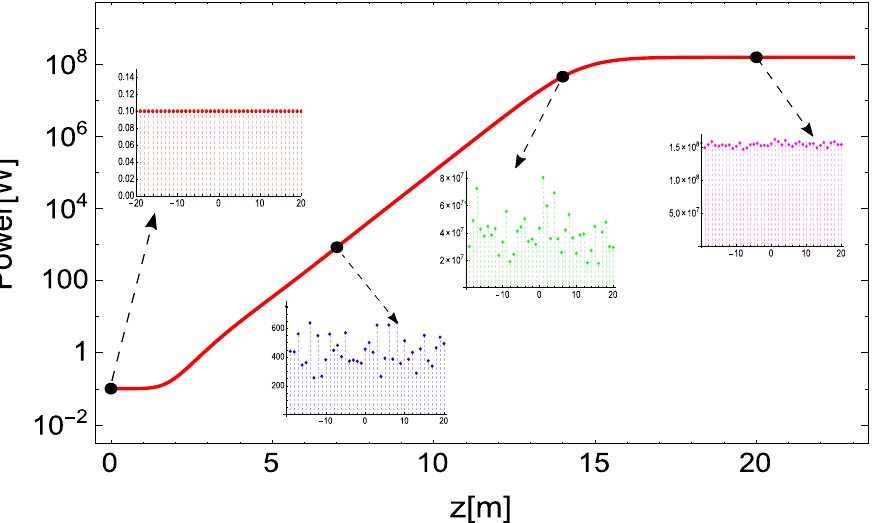
Figure 11. Same parameters as in Figure 10 with the inclusion of the saturation. The slices have a flat distribution in z , and each is characterized by an initial seed of 0.1 W. The vertical axis is in log-scale; the insets are plotted in linear